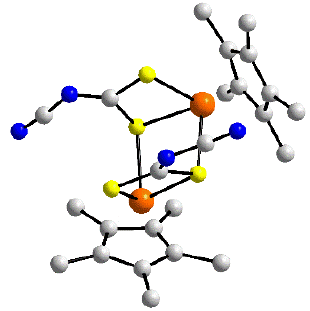
Figure 5. Molecular structure of one of the independent molecules of {Cp*Rh[S 2 C=N(CN)]} 2 in 9